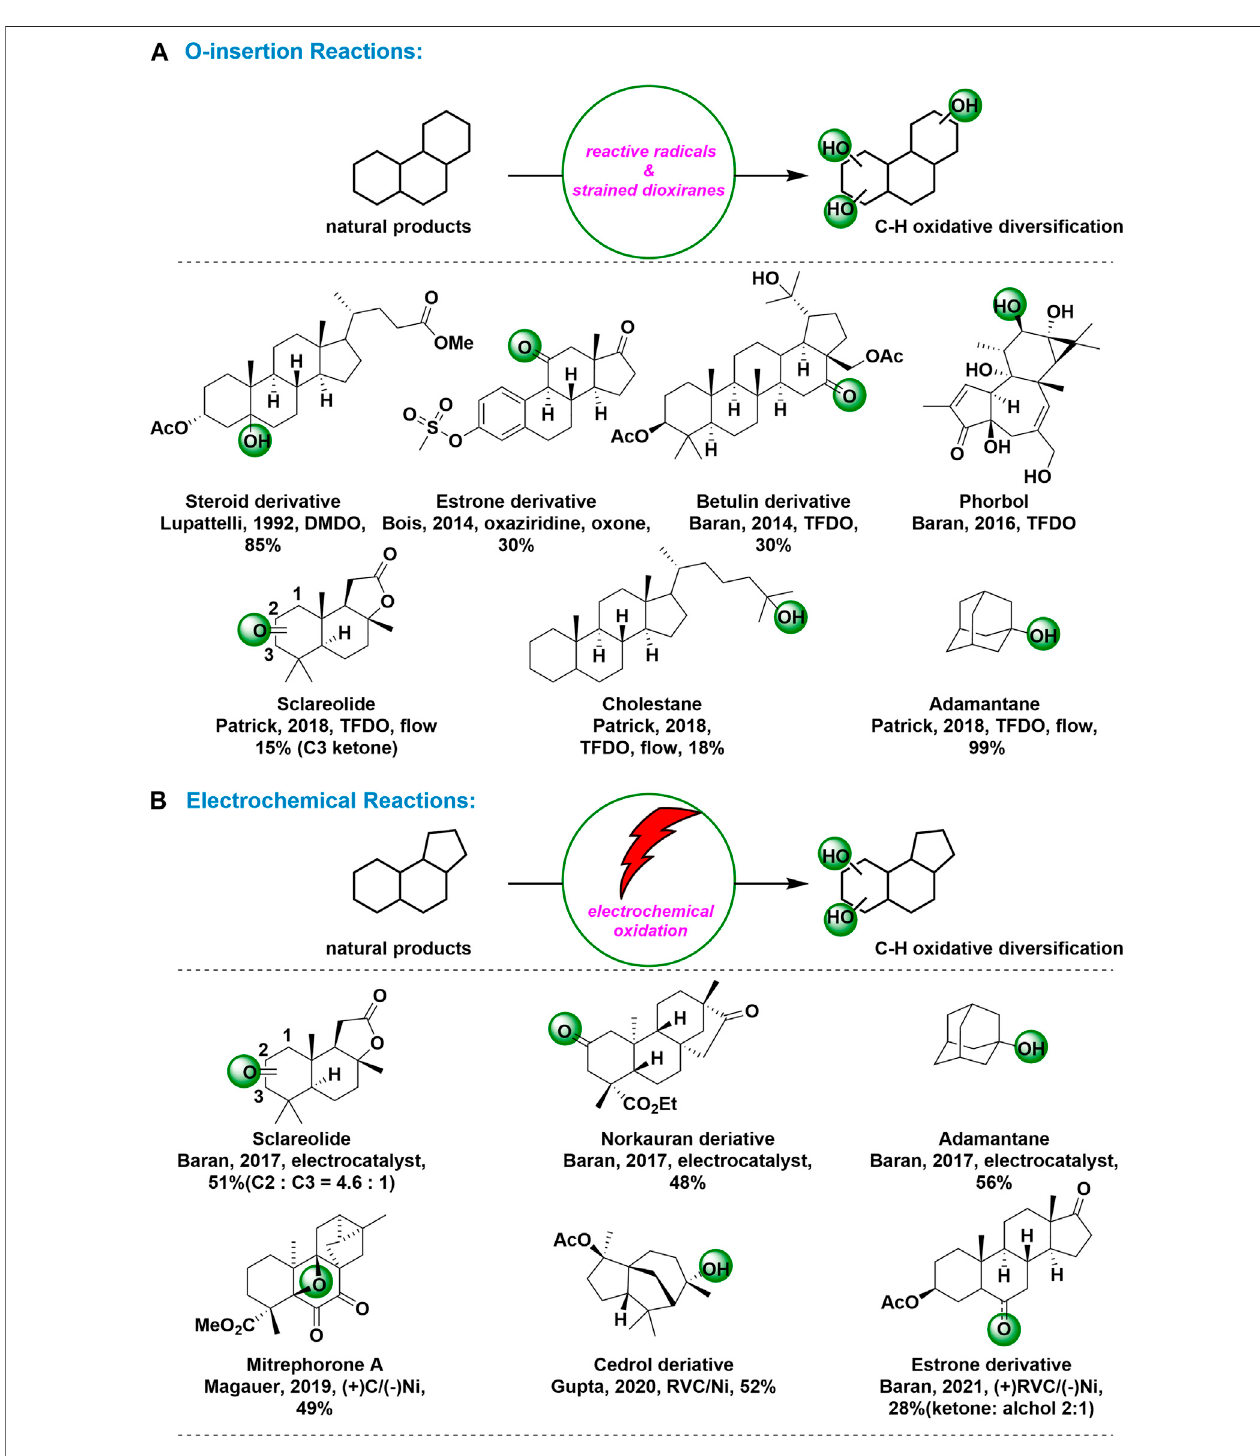
FIGURE 1 | C-H Oxidations for natural products and complex molecules: (A) O-insertion reactions for C-H oxidation; (B) Electrochemical reactions for C-H oxidation.